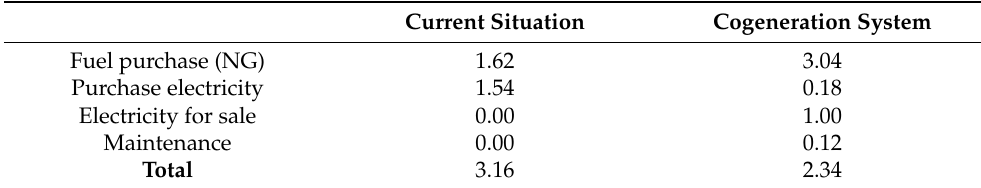
Table 13. Annual economic balance for the chosen alternative (M € ).